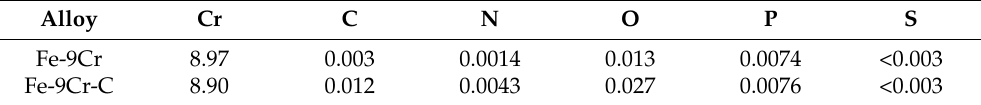
Table 1. Concentrations of the composition in samples used in this study (wt.%).